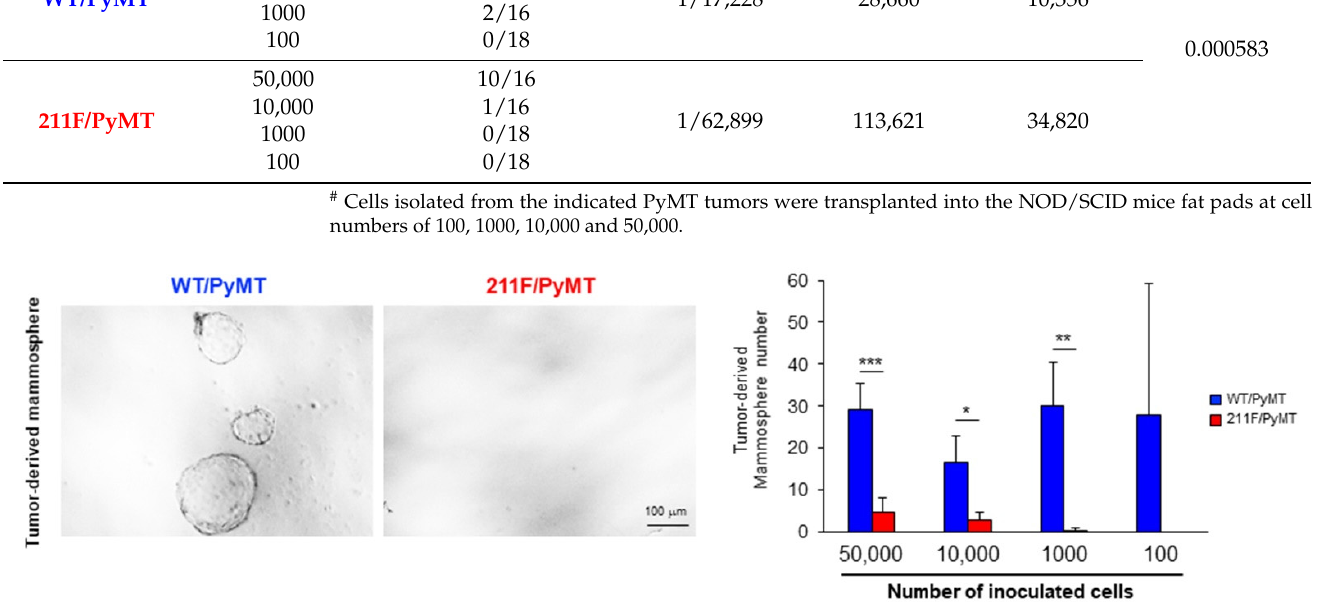
Figure 4. Y211 phosphorylation is important for maintaining the stemness of cancer cells in vivo. ( Left ), representative mammosphere formation is shown. ( Right ), tumor cells isolated from limiting dilution-derived tumor tissues were inoculated in suspension culture, and the formed mammospheres were counted. Bar, standard deviation. *, p < 0.05; **, p < 0.01; ***, p < 0.001 as determined by Student’s t